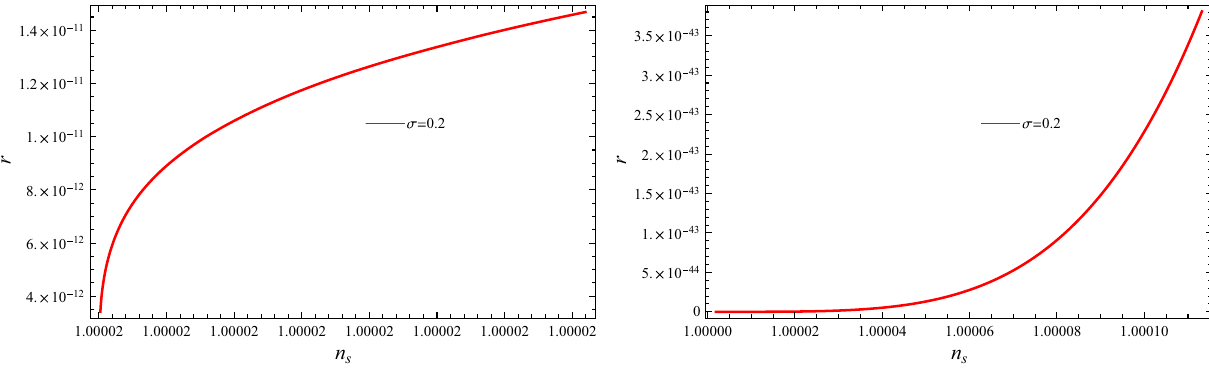
Fig. 3 Plot of r versus n s for GCG model in weak (left panel) and strong (right panel) dissipative regimes for positive potential with n = −